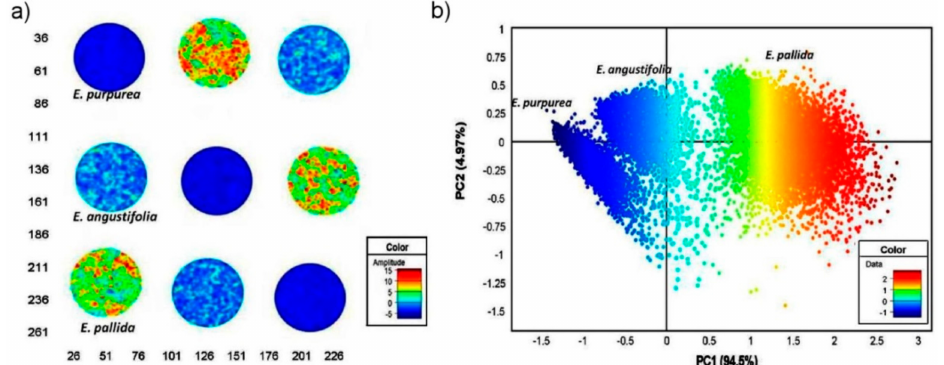
Figure 9. The analysis of NIR images of medicinal plants. PCA score image (t1) of Echinacea sp . leaf powders based on color amplitudes ( a ). The corresponding score plot (PC1 vs. PC3) shows minimal separation of the pixel clusters ( b ). (EAL— E. angustifolia leaf, EPL— E. purpurea leaf, EPaL— E. pallida leaf). Reproduced in compliance with CC BY license from Ref.